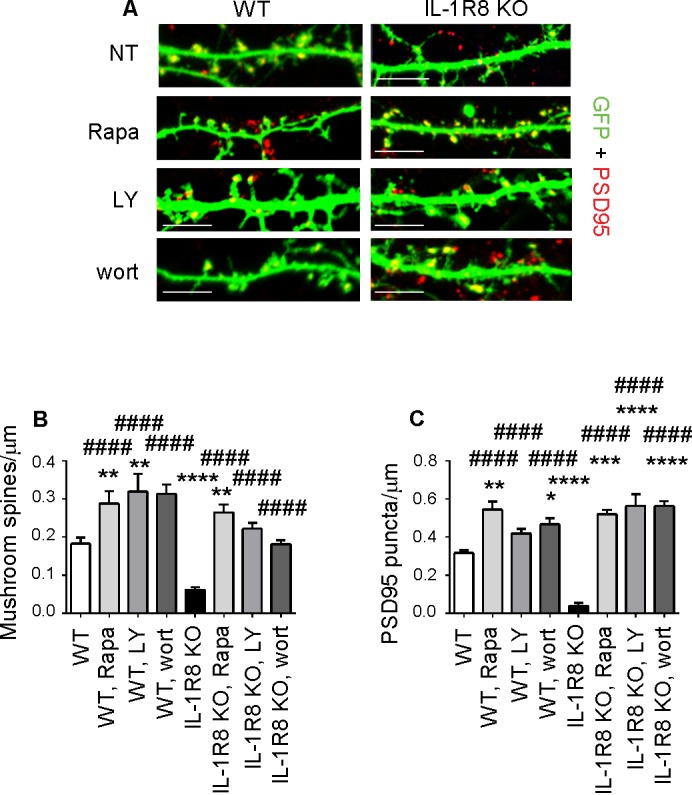
Inhibition of mTOR signalling restores LTP in IL-1R8 KO neurons.(A) PSD-95 immunocytochemical staining of GFP-transfected 16 DIV hippocampal cultures from WT or IL-1R8 KO mice. At DIV 15 neurons were treated with rapamycin (Rapa, 20 nM), LY294002 (LY, 30 μM) or wortmannin (wort, 20 nM) overnight (14 hr). Scale bar, 5 μm. (B) Quantitative analysis of mushroom spine density. Number of analyzed neurons: 36 (WT), 17 (WT, Rapa), 10 (WT, LY), 5 (WT, Wort), 42 (IL-1R8 KO), 35 (IL-1R8 KO, Rapa), 28 (IL-1R8 KO, LY), 30 (IL-1R8 KO, Wort); one-way ANOVA analysis of variance followed by post hoc Tukey test. (C) Quantitative analysis of PSD-95 puncta density. Number of analyzed neurons: 17 (WT), 7 (WT, Rapa), 9 (WT, LY), 11 (WT, Wort), 9 (IL-1R8 KO), 15 (IL-1R8 KO, Rapa), 15 (IL-1R8 KO, LY), 18 (IL-1R8 KO, Wort); one-way ANOVA analysis of variance followed by post hoc Tukey test. Data indicate that inhibitors of the mTOR pathway restore synaptic potentiation. * indicates significance compared to WT, # indicates significance compared to IL-1R8 KO.